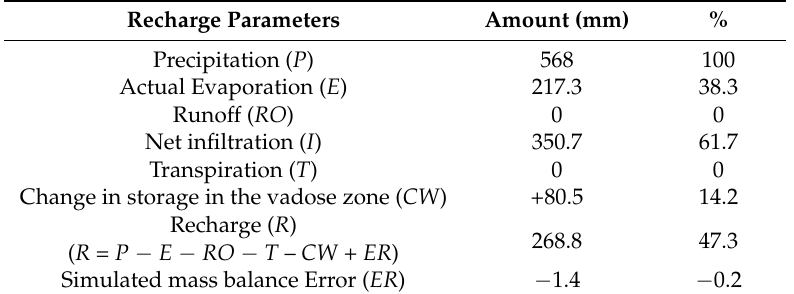
Table 6. Simulated water balance components from March to December 2014 (in mm and % of